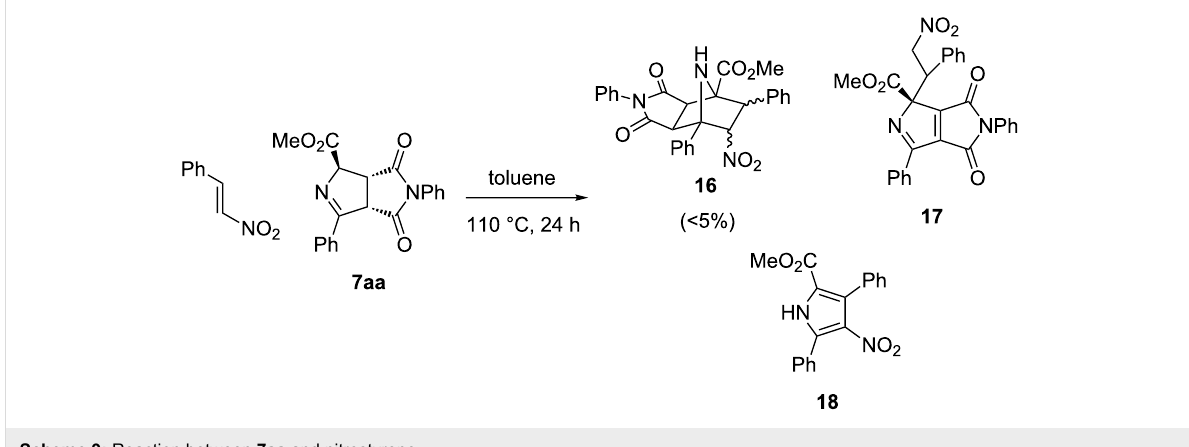
Scheme 9: Reaction between 7aa and